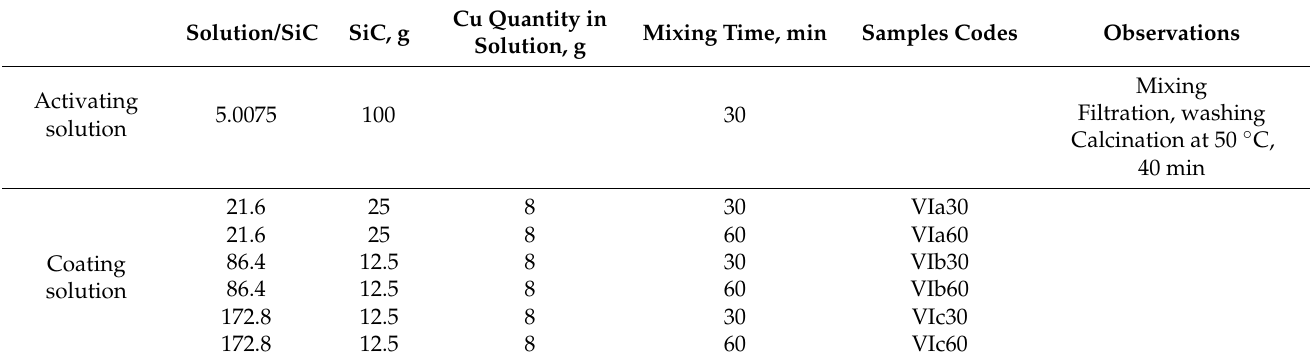
Table 2. Working